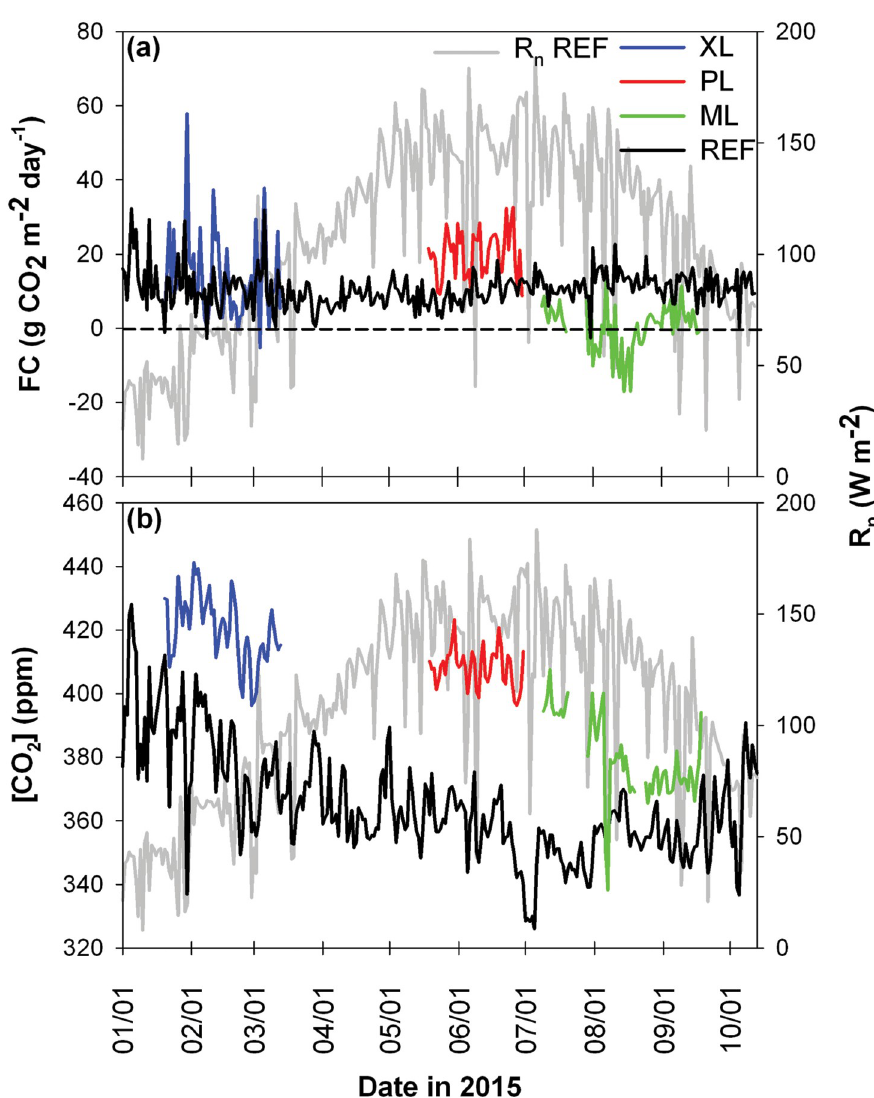
Fig 3. Daily values of FC for each site. Daily total values of FC (a) and average values of CO 2 concentration (b) for the XL, PL, ML, and REF sites over the study period, with daily average values of net radiation ( R n ) at REF shown as a reference.